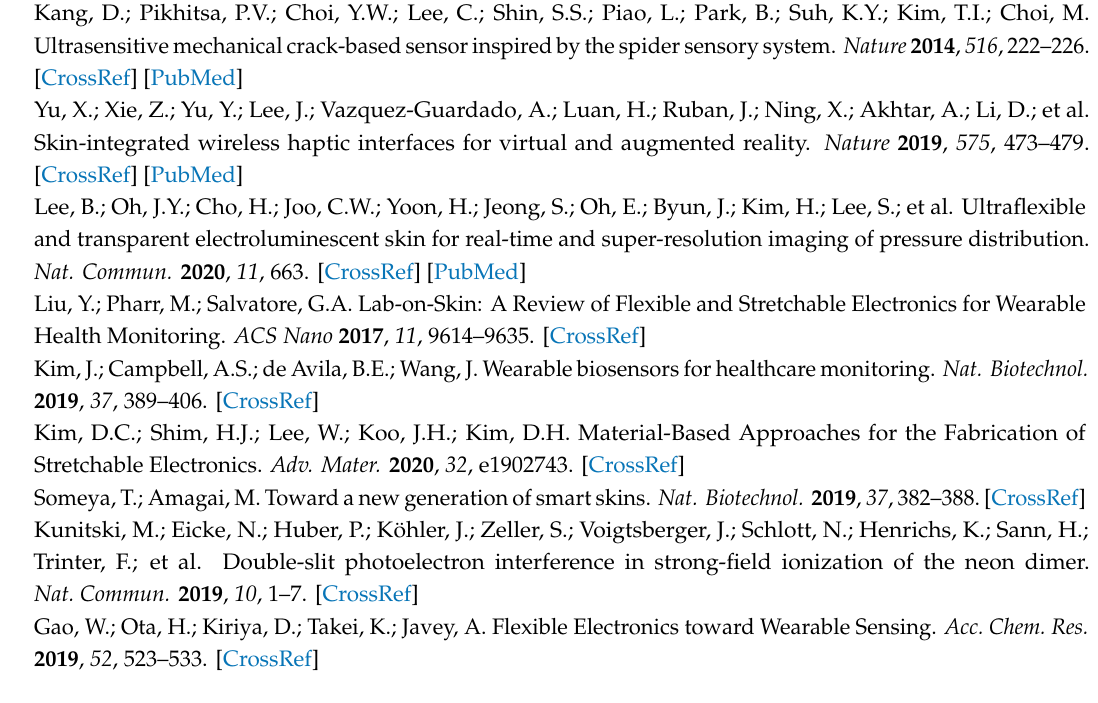
Figure S1: (a) Surface topography of tissue in microscope. (b) Bottom electrode after screen printing on tissue. (c,d) Adhesion of silver paste used in bottom electrode; Figure S2: SEM images about the surface morphologies of tissue. (a) Surface distribution. (b) Local distribution. (c) Single fiber distribution; Figure S3: Consecutive compression tests on the sensitive layer. (a) Intrinsic tissue. (b) Tissue and CNT composites; Figure S4: Degradation process of all tissue-based sensors. (a) Before combustion. (b,c) Combustion process. (d) Combustion degradation completed; Figure S5: (a) The temperature-current curve of pressure sensor under constant pressure loading (pressure: 2 kPa, voltage: 3 V). (b) The pressure-temperature functions under varies voltage; Figure S6: Schematic diagram of Bluetooth wireless system; Video S1: Combustion process of all tissue-based sensor; Video S2: Continuous breath process of wireless